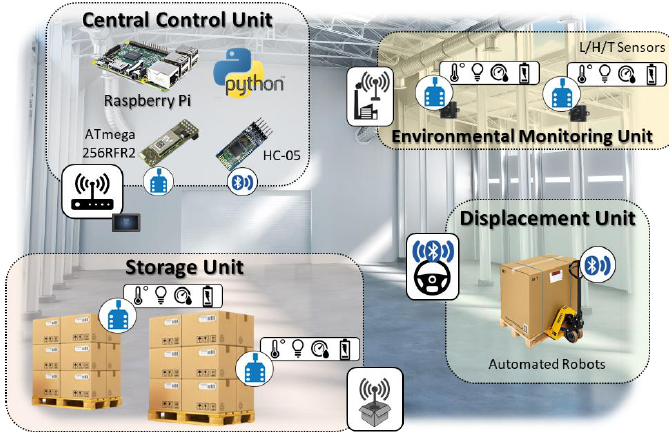
Figure 1. Top-level representation of the overall implemented architecture.